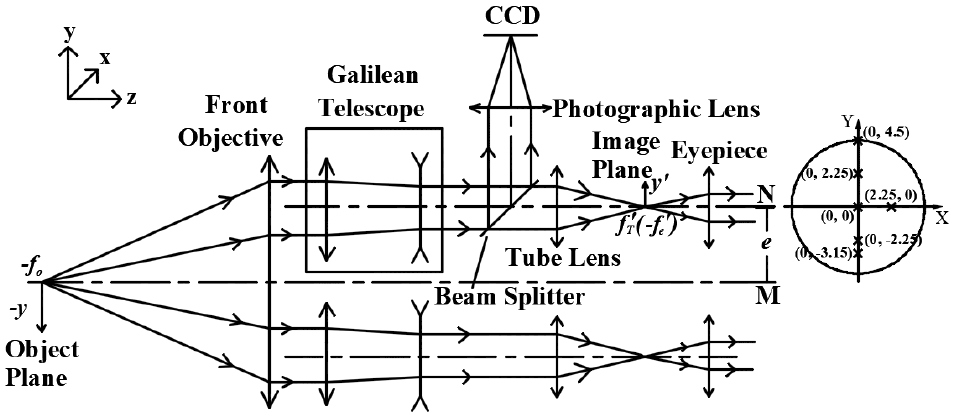
Figure 1. Optical principle of the digital slit-lamp microscope (DSLM).